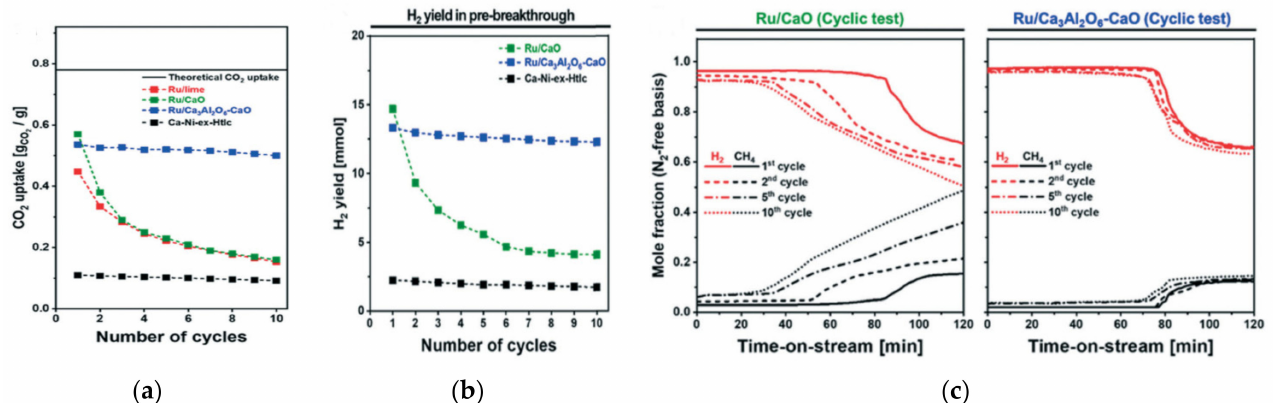
Figure 14. Comparison of Ru/CaO, Ru/Ca 3 Al 2 O 6 –CaO, Ru/lime, Ca–Ni-ex-HTlc hybrid material performance: ( a ) CO 2 capture, ( b ) H 2 yield, ( c ) breakthrough curves of H 2 and CH 4 for Ru/CaO and Ru/Ca 3 Al 2 O 6 –CaO in the 1st , 5th and 10th cycles. (Reprinted with permission from [137]. 2011, Kim et